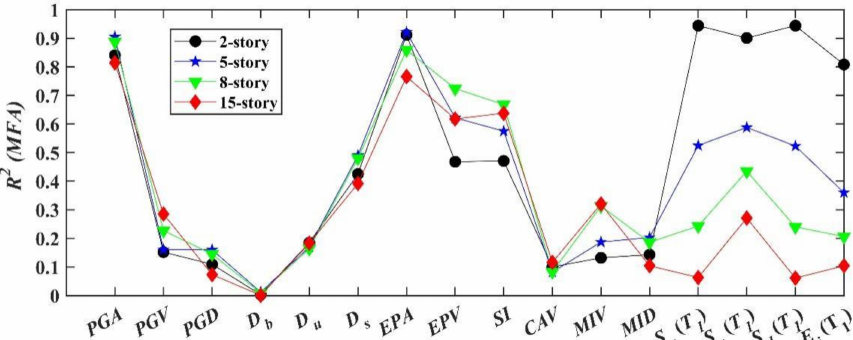
Figure 8. R 2 of IMs and MFA , obtained via the cloud analysis of four typical structures subjected to pulse-like ground motions.